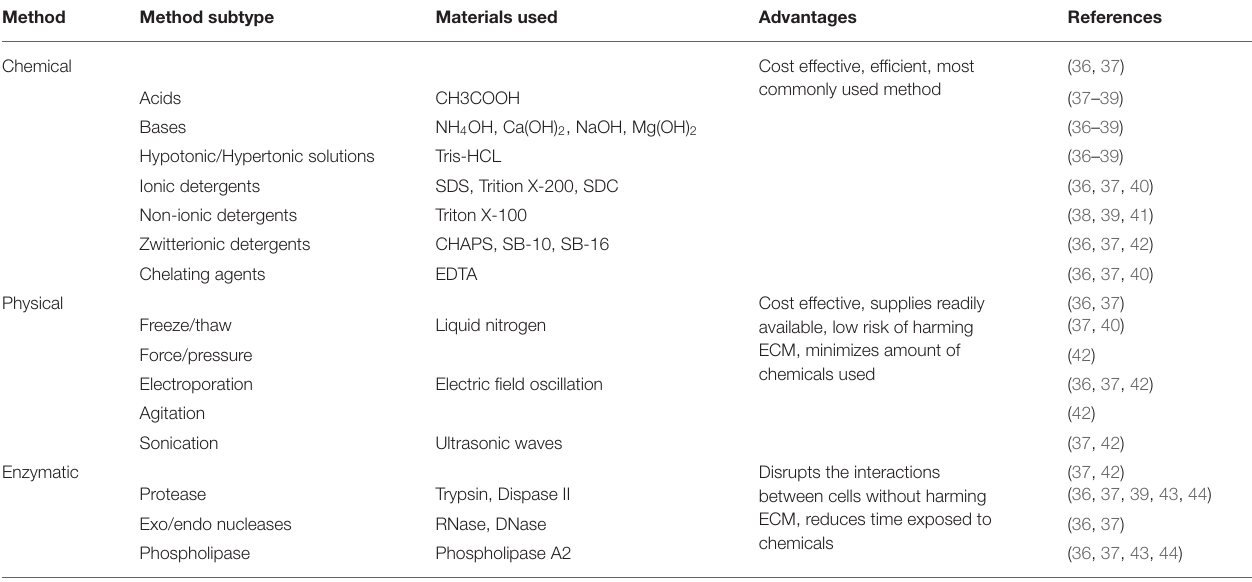
TABLE 1 | Current methods of decellularization and their